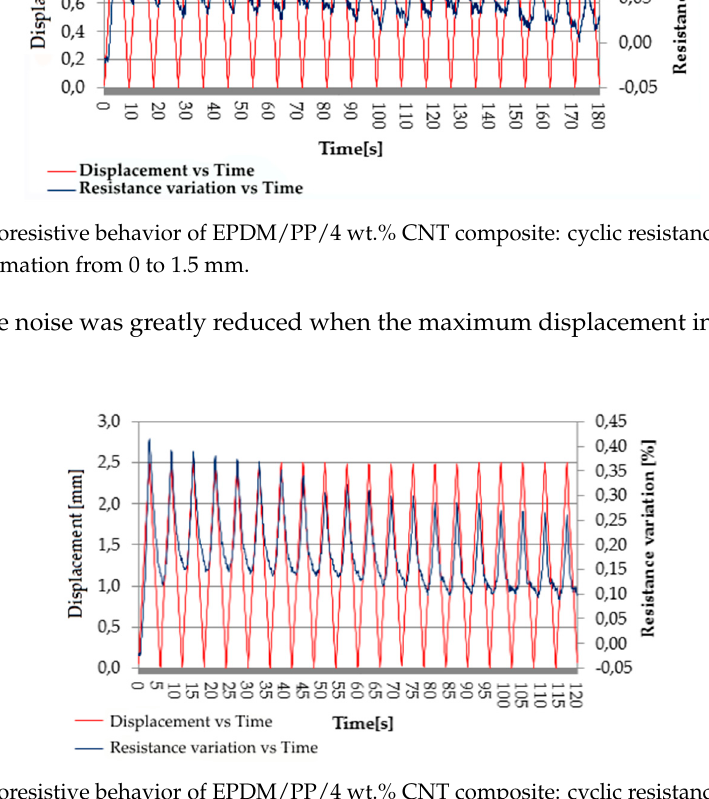
Figure 7. Piezoresistive behavior of EPDM/PP/4 wt.% CNT composite: cyclic resistance variation due to cyclic deformation from 0 to 2.5 mm (displacement speed: 50 mm/min).